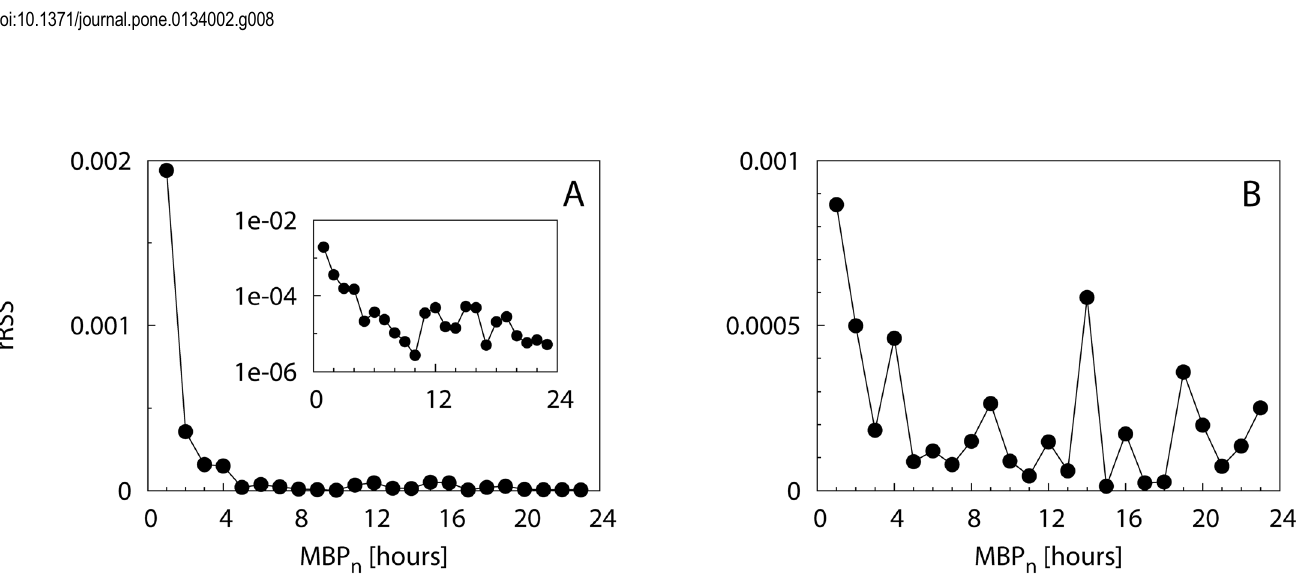
Fig 9. Field data: Renormalized sum of squared residuals at large timescales. The rSSR is calculated over pairs of survival curves with Δ MBP = 2 h (stars), 4 h (empty squares), 6 h (filled squares) and 8 h (empty circles) for bigeye scad (A) and yellowfin tuna (B). Insets: the same in semi-logarithmic scale.